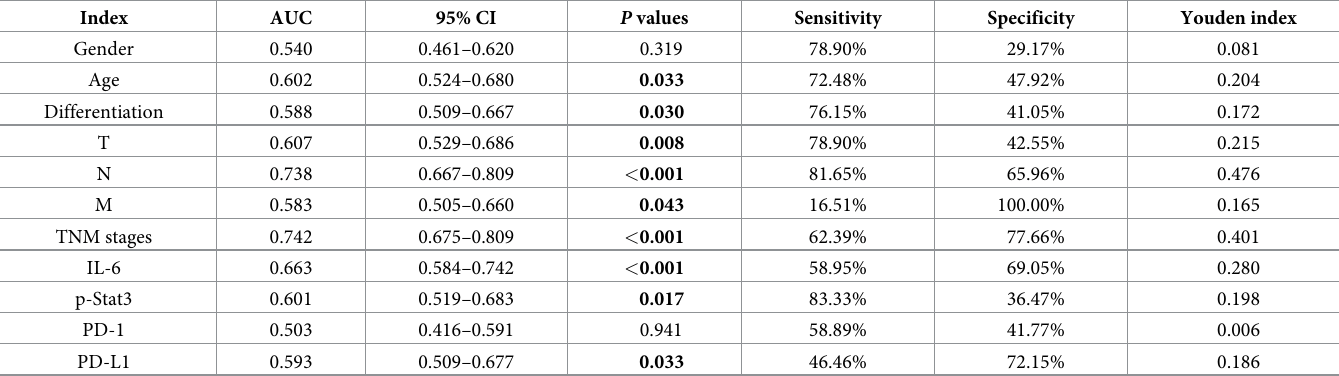
Table 2. AUCs (area under the curves) for various bio-indicator in gastric cancer.